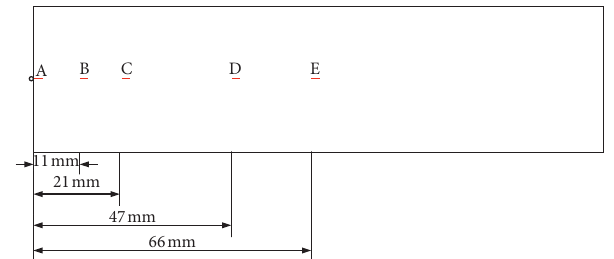
Figure 9: Five areas (A B, C, D, and E) of CFRP laminated plates.